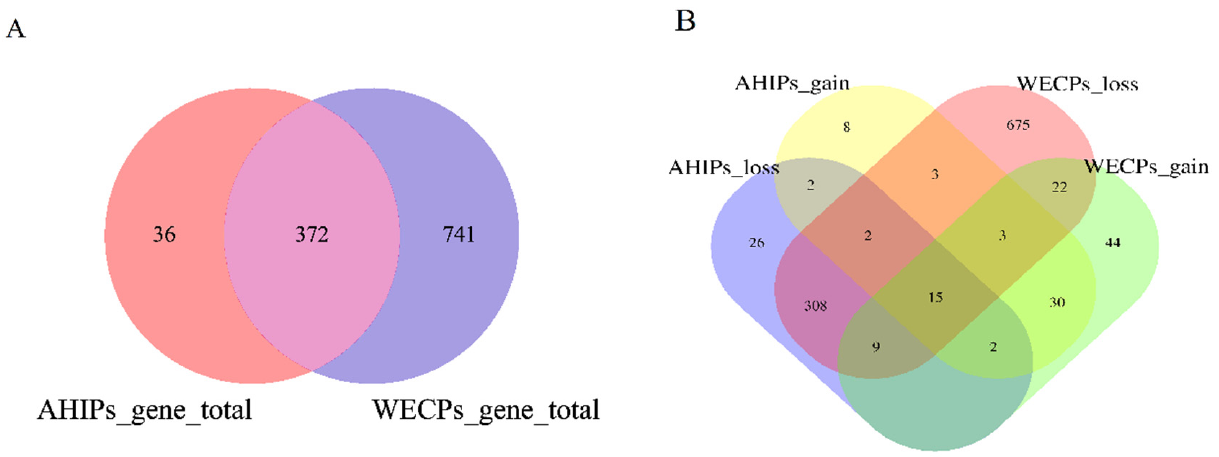
Figure 4. Venn diagram of CNVRs and related genes in AHIP and WECP populations. ( A ) Venn diagram of annotated total genes in AHIP and WECP populations. ( B ) Venn diagram of different CNVR event annotated total genes in AHIP and WECP populations.